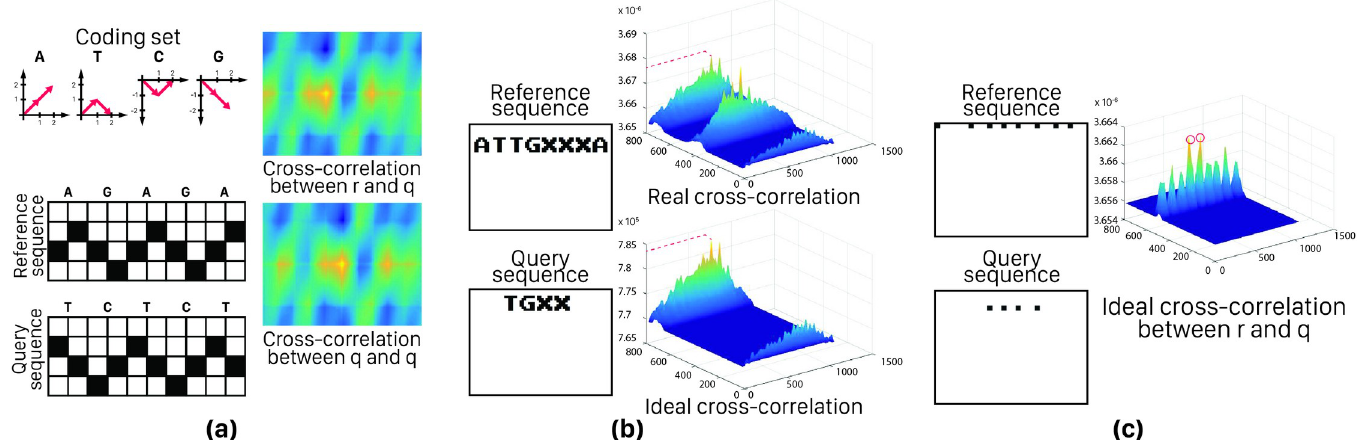
Fig 3. Three types of output noises; a) Overlap noise: code overlapping as the result of DV-Curve encoding method results in output peaks which mislead to sequence matching, b) System noise: output peak value decreases when realistic condition is simulating, c) Neighbor noise: adjacent peaks (as the result of either valid peaks or high-altitude noises) avoids proper indel